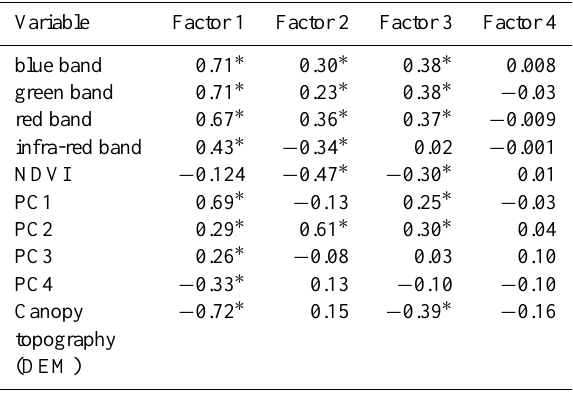
Table 4. Pearson’s correlation coefficients between factor axes and image variables: four spectral bands, Normalized Difference Vegetation Index (NDVI), Principal Component transformation to the IKONOS-2 image (PC), and canopy topography derived from DEM-SRTM